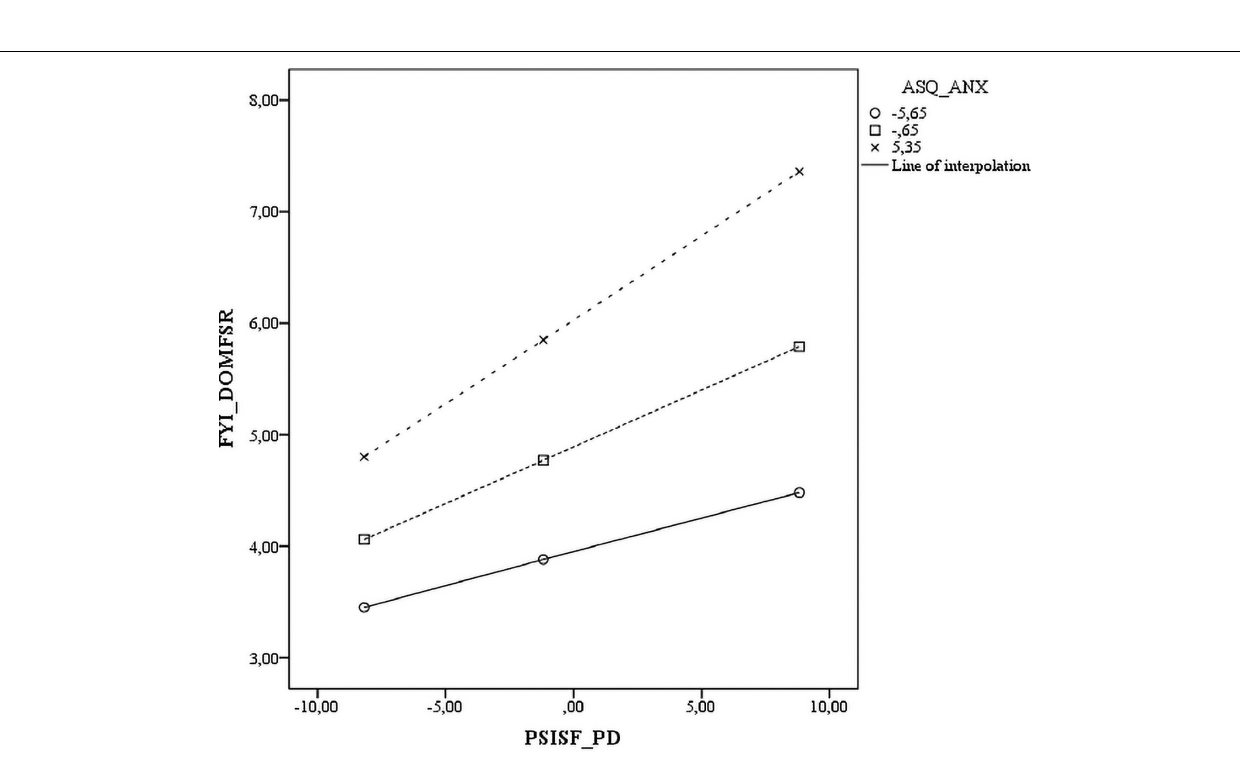
FIGURE 2 | Scatter plot of the interaction between anxious attachment style and parental distress on the sensory regulation